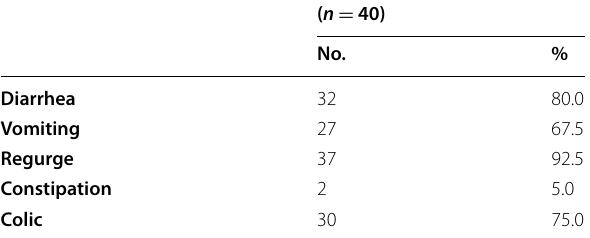
Table 2 GI manifestations of the studied cases